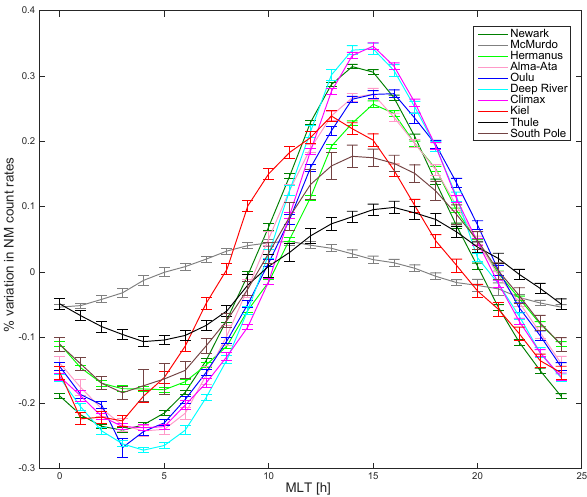
Figure 1. Percentage change in neutron monitor counts with respect to a 10-day running mean, averaged for each hour of the day (in MLT) for all available days of data for each neutron monitor. The colours represent different neutron monitors given by the key in the top-right of the figure. The error bars are the standard error on the